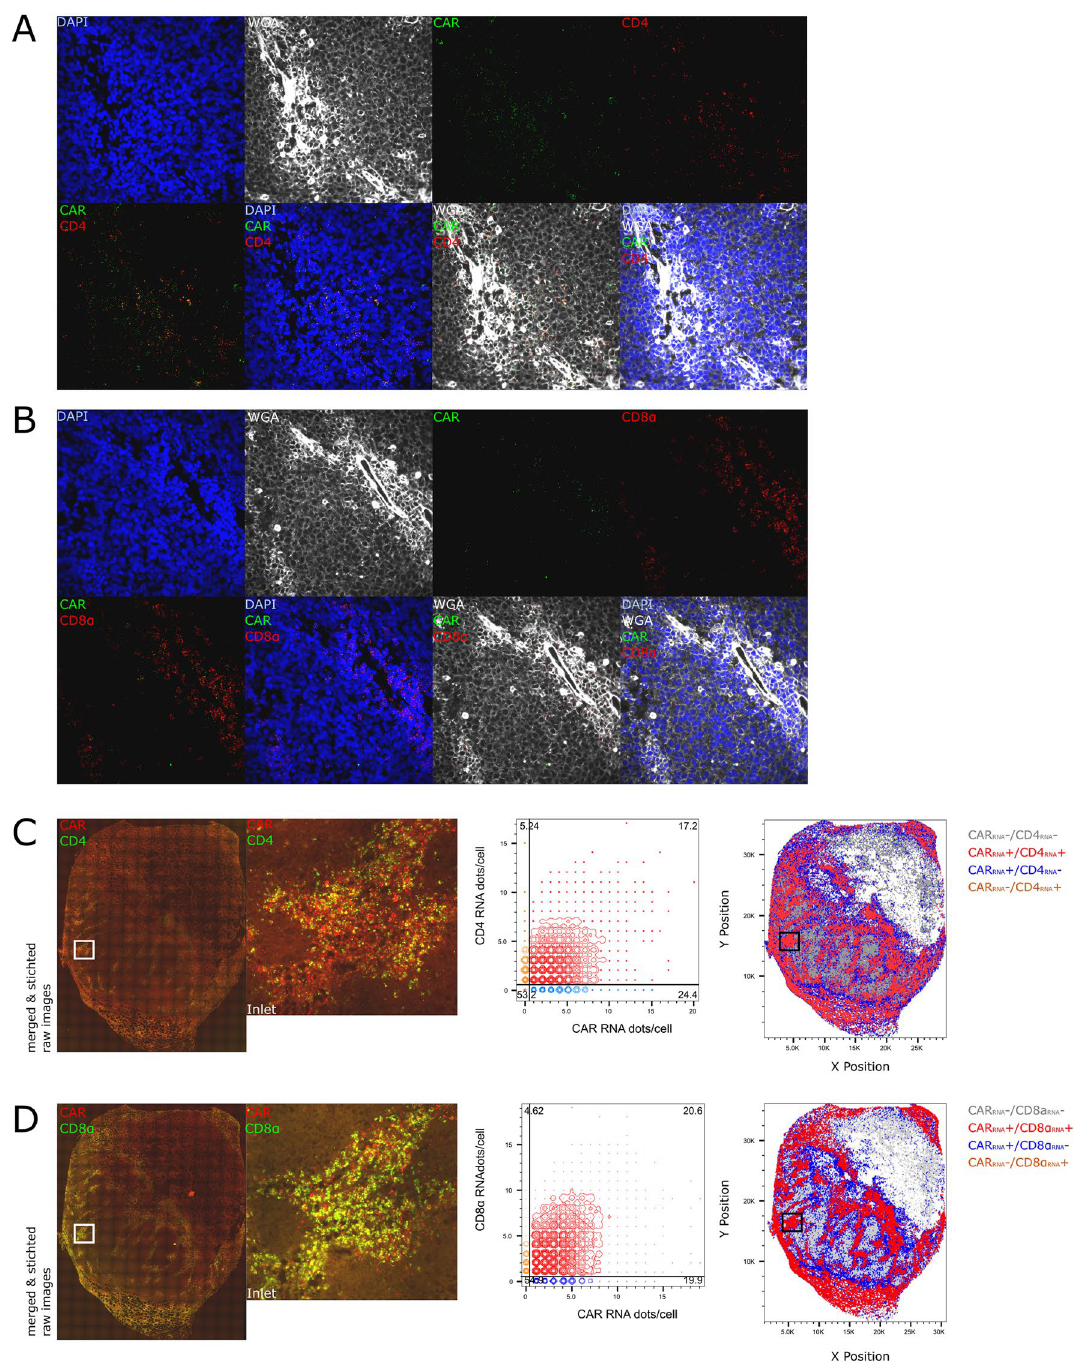
Figure 3. CD4 and CD8 CAR T cells are present in the tumor and express IFNγ. CAR T cell lineage phenotyping was done with CAR RNA FISH in combination with DAPI, WGA and CD4 or CD8α RNA FISH on a CAR+ CD19+ FFPE BE2 neuroblastoma xenograft. Representative images from the tile scans are shown for CAR RNA and CD4 RNA ( A ) or CD8α RNA ( B ) as well as nuclear and plasma membrane counterstaining. The single images from the tile scan were analyzed by RRS. The single tiles of the CAR (red) and CD4 (green) RNA FISH channels were used to create whole tissue overview images to visually assess cells distribution and the whole tissue RRS analysis of the two RNA FISH, the WGA and DAPI channel of each single tile shows the distribution of the CAR+ CD4+ and CD4− T cells in a representative CAR+ BE2 tumor section (n = 3) ( C ). The single tiles of the CAR (red) and CD8a (green) RNA FISH channels were used to create whole tissue overview images to visually assess cells distribution and the whole tissue RRS analysis of the two RNA FISH, the WGA and DAPI channel of each single tile shows the distribution of the CAR+ CD8+ and CD8− T cells in a representative CAR+ BE2 tumor sections (n = 3) ( D